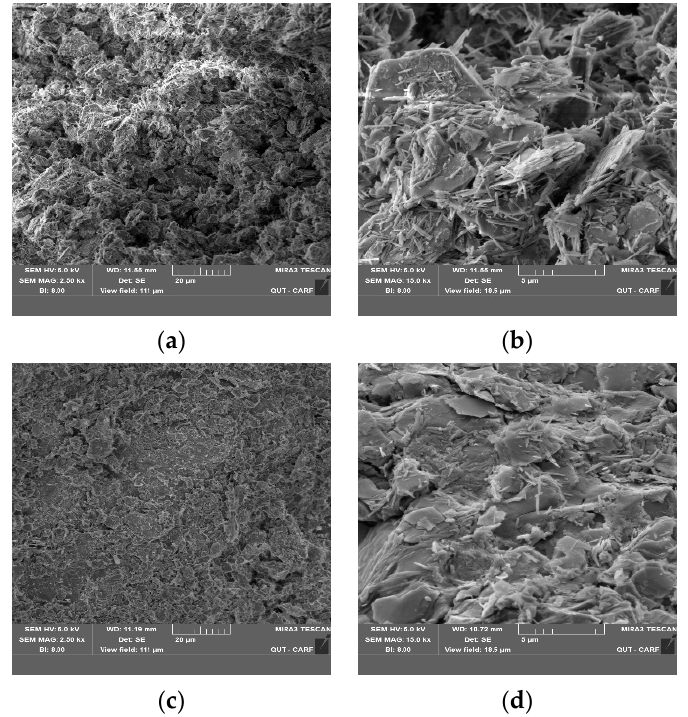
Figure 11. SEM images of the ( a ) untreated soil with a magnification of 2500; ( b ) untreated soil with a magnification of 15,000; ( c ) XG-treated soil with a magnification of 2500 ( d ) XG-treated soil with a magnification of 15,000.